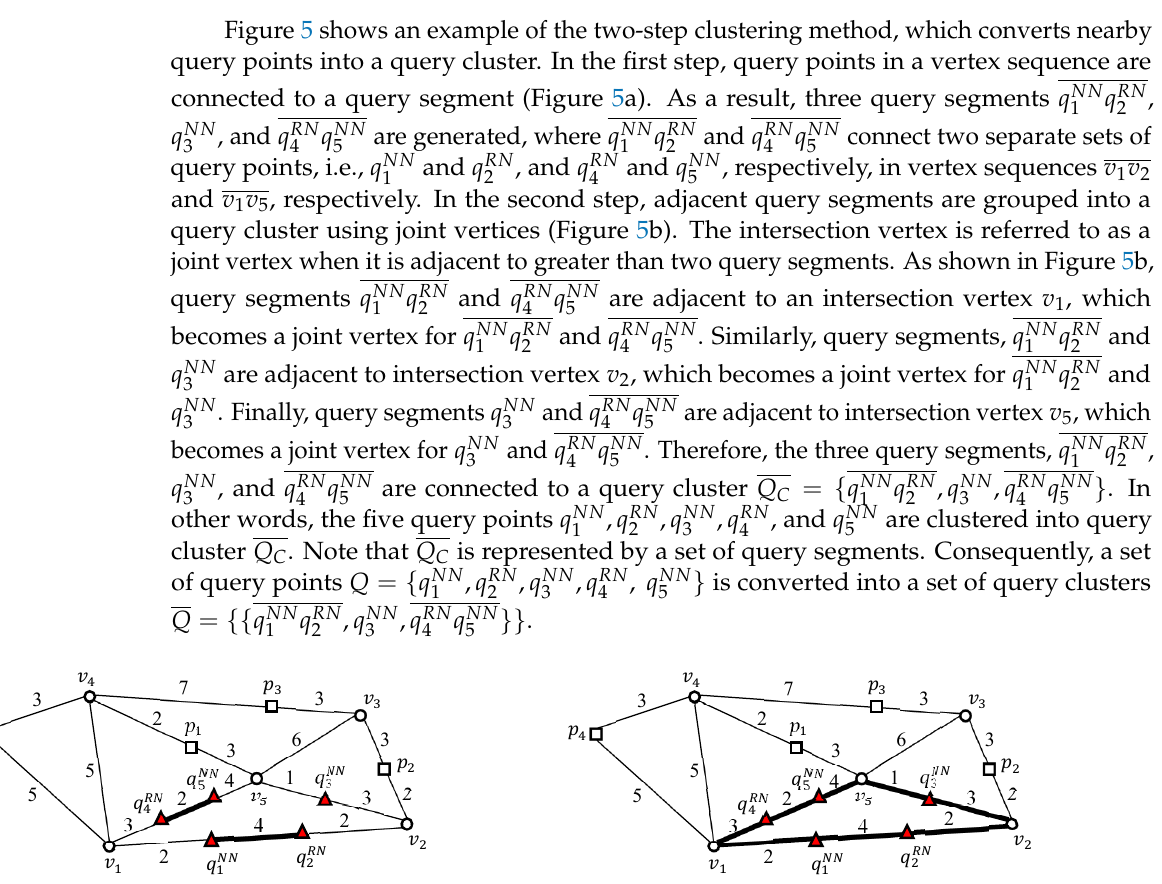
, q RN , q NN , q RN , and q NN . 2 3 5 1 4